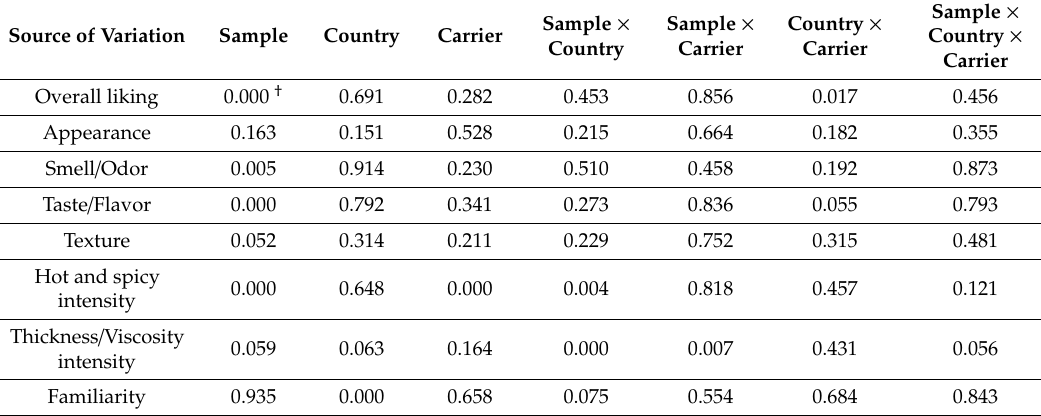
Table 5. Influence of sample, country, carrier food main e ff ects, and their interaction e ff ects on the ratings of liking, intensity, and familiarity of dipping sauce